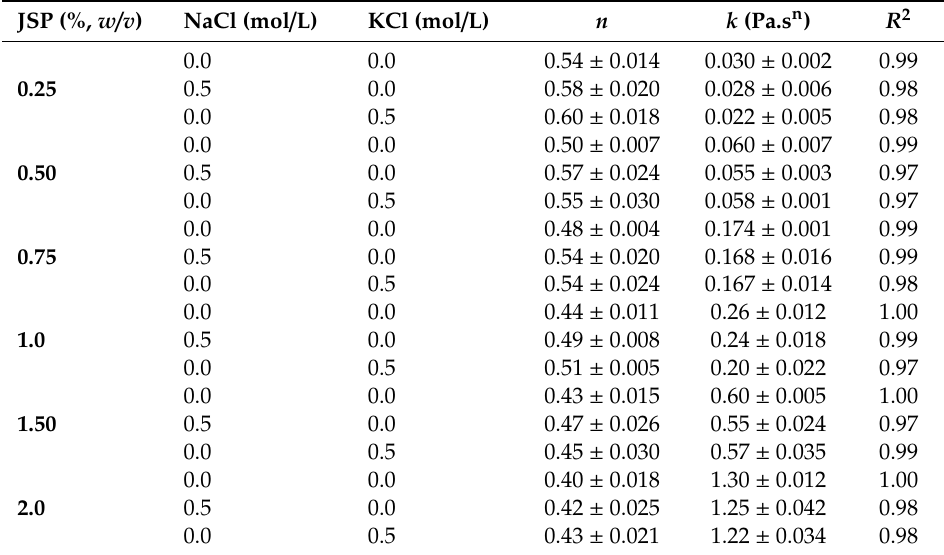
Figure 6. Flow behavior of JSP aqueous solutions at different concentrations ranging from 0.25% to 2.0% ( w/v ) at 25 °C. Table 4. Consistency and flow behavior index of JSP solutions in water and monovalent salts.